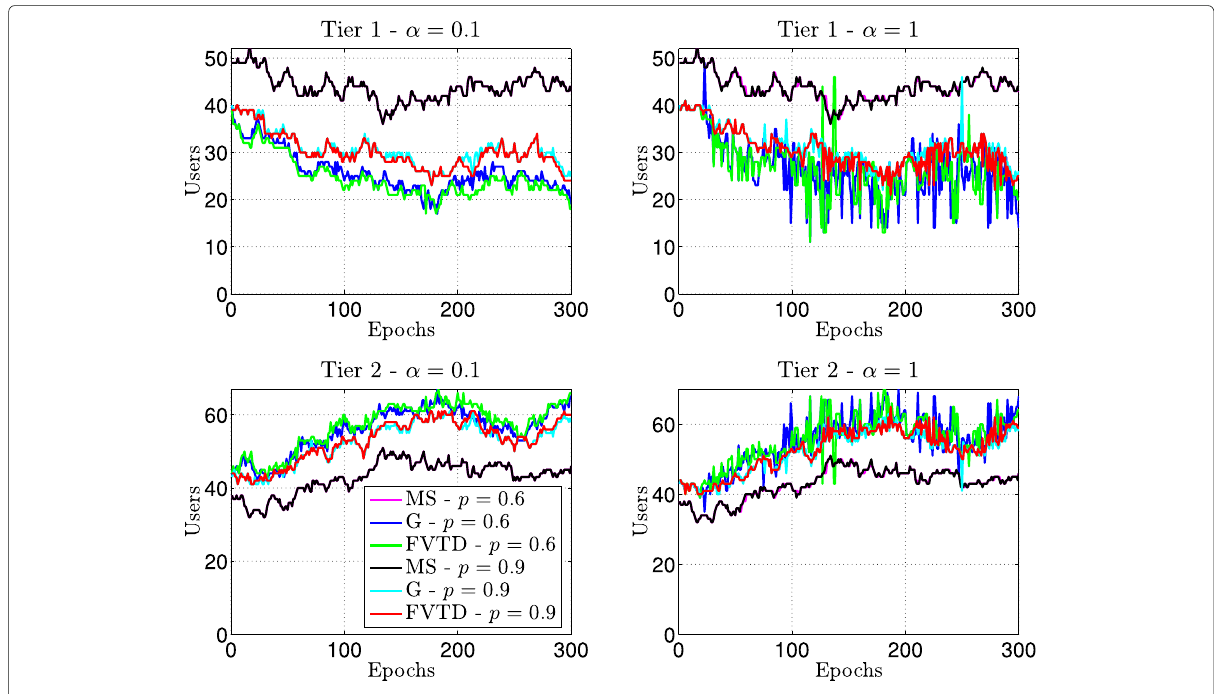
Fig. 8 Evolution of user association in tier 1 and tier 2